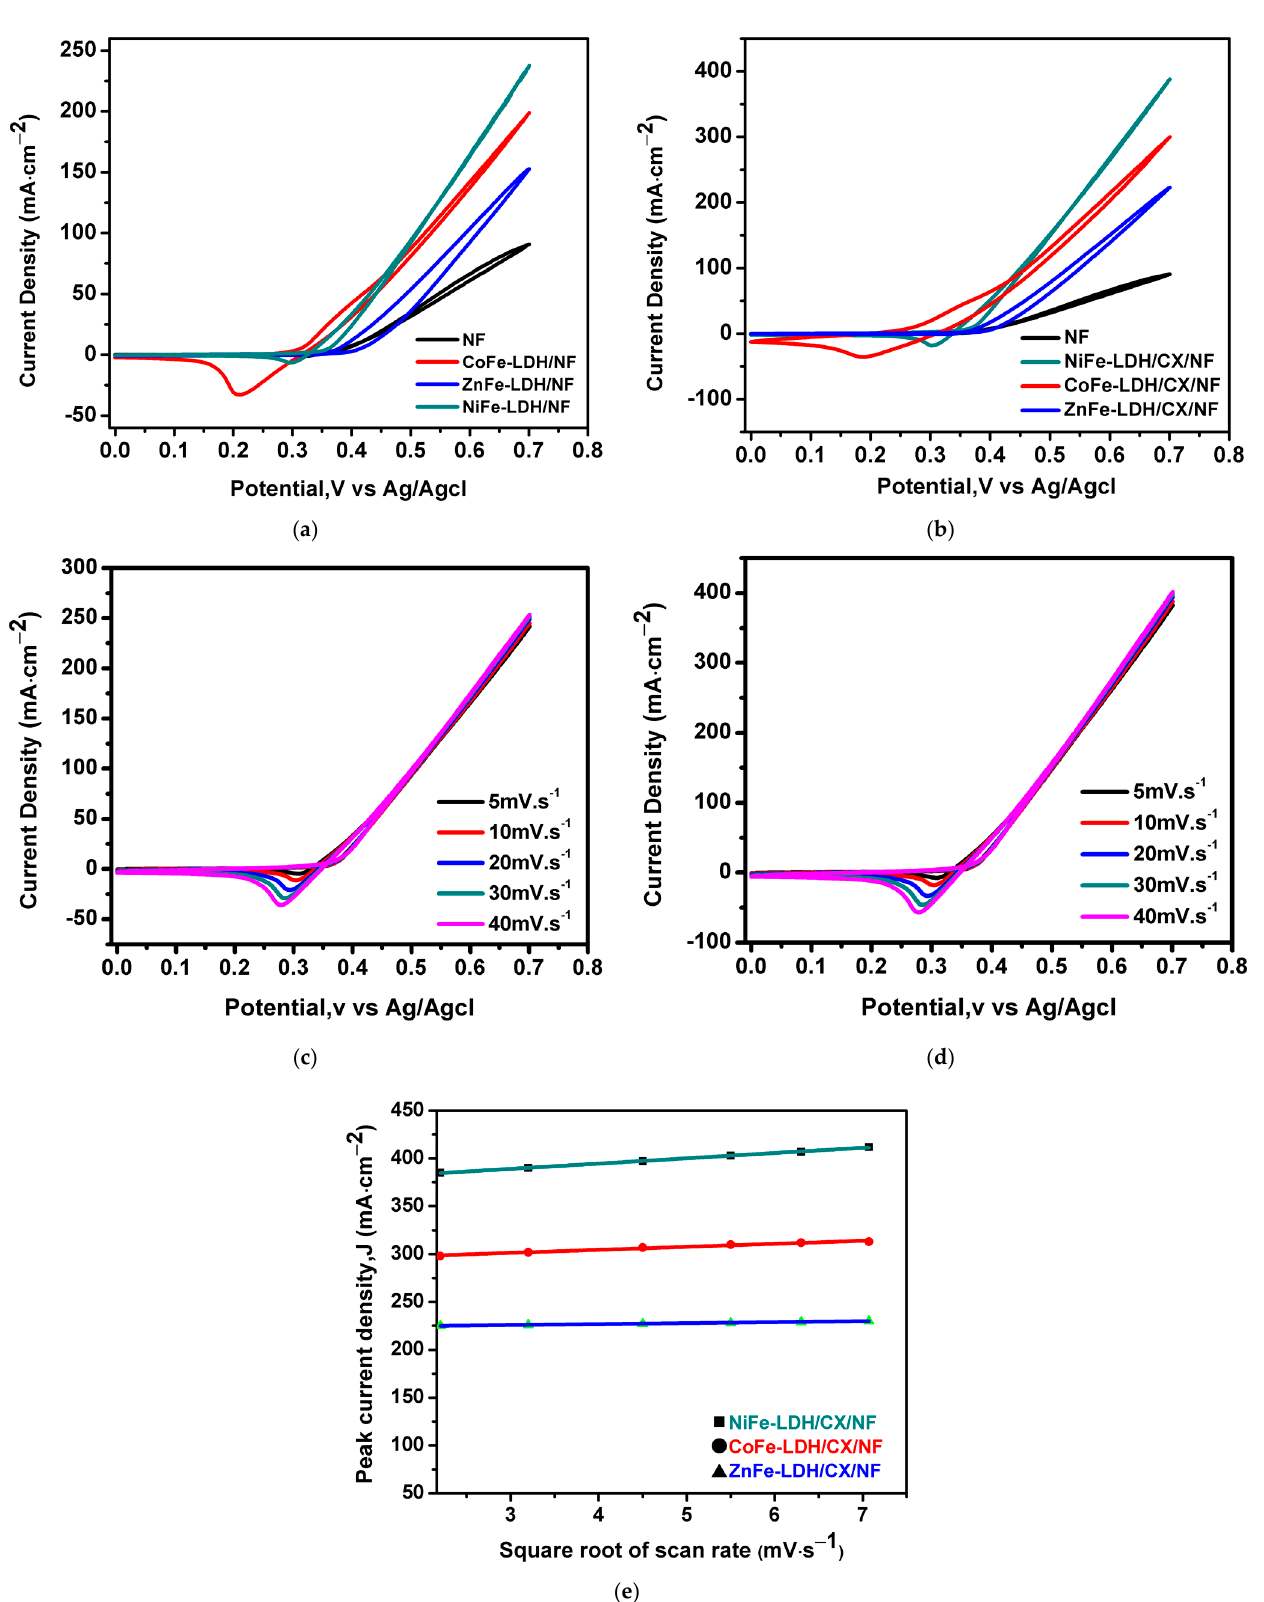
Figure 7. CVs at 1 M KOH + 0.5 M MeOH of ( a ) LDHs/NF at 10 mV/s, ( b ) LDHs/CX/NF at 10 mV/s, ( c ) NiFe-LDH/NF at different scan rates, and ( d ) NiFe-LDH/CX/NF at different scan rates. ( e ) Linear relationship between the anodic peak currents and the square root of the scan rate for all nanohybrids with CX.